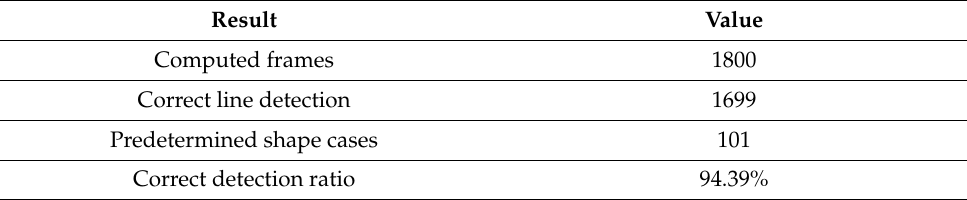
Table 3. Line detection